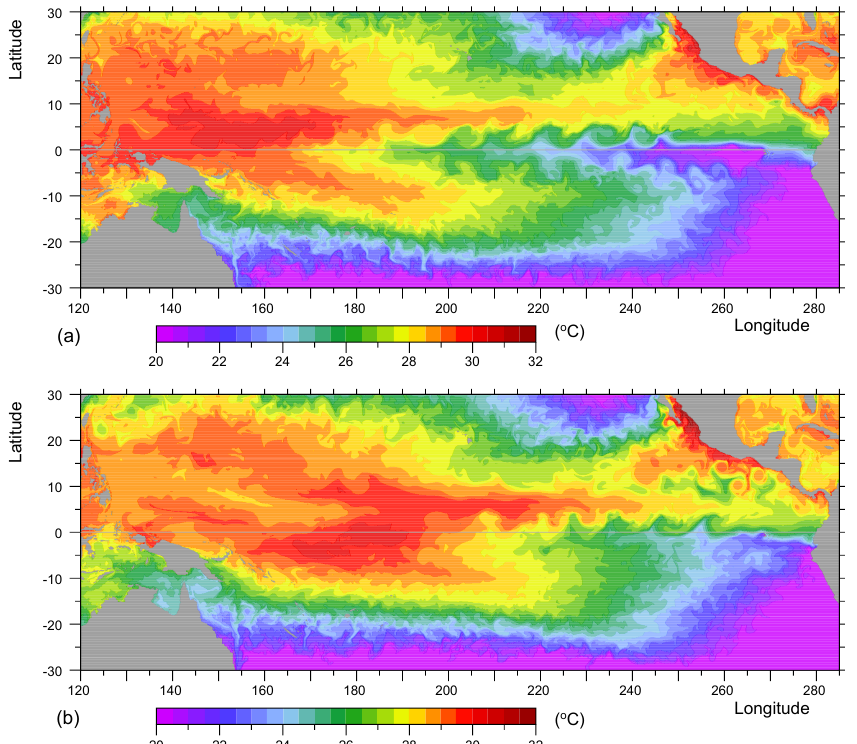
Figure 13. Surface temperature ( ◦ C) from the model in late September (a) 1981 and (b) 1982. (Values below 20.5 ◦ C are